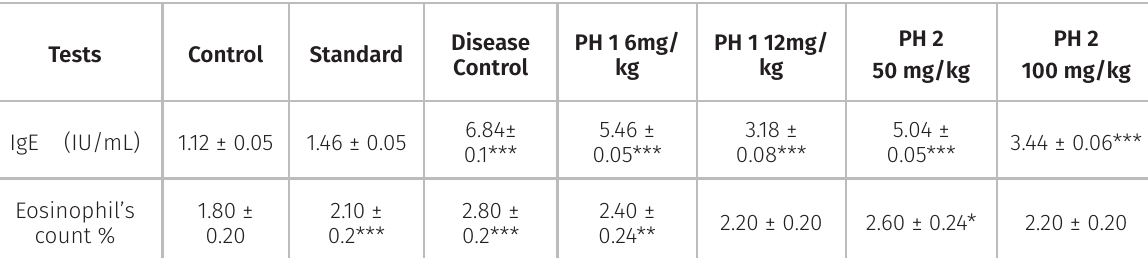
Table VII. Effects of polyherbal products on IgE and eosinophil’s count of mice in control and treatment